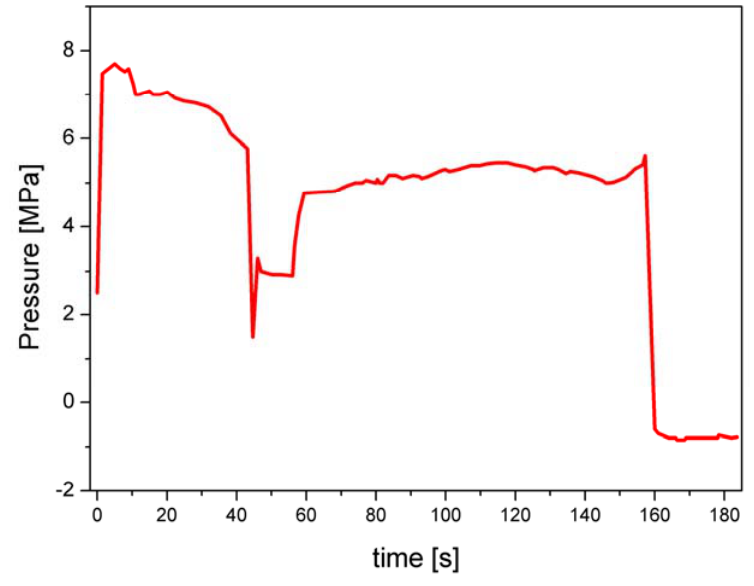
Figure 1. Pressure-time diagram of SMC moulding process (Formulation C) used for the calculation of optimal sampling